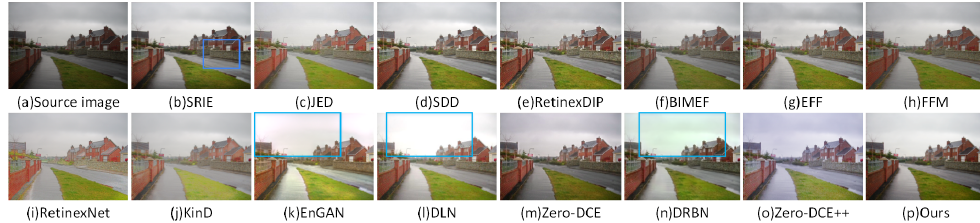
Figure 9. Visual effect of the cloudy weather images in the NPE [37] dataset after being enhanced.